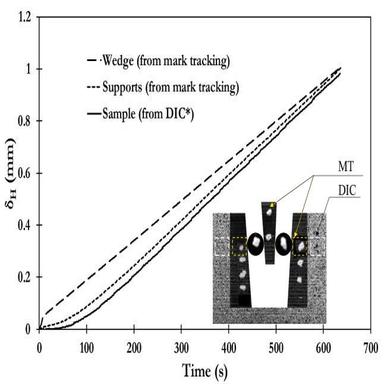
Evolution of crack opening displacement δH versus time during a WST, which can be obtained from the vertical displacement of the wedge (Wedge), from markers placed on the two metallic supports (Supports) and from subsets placed close to the border of the sample (Sample).